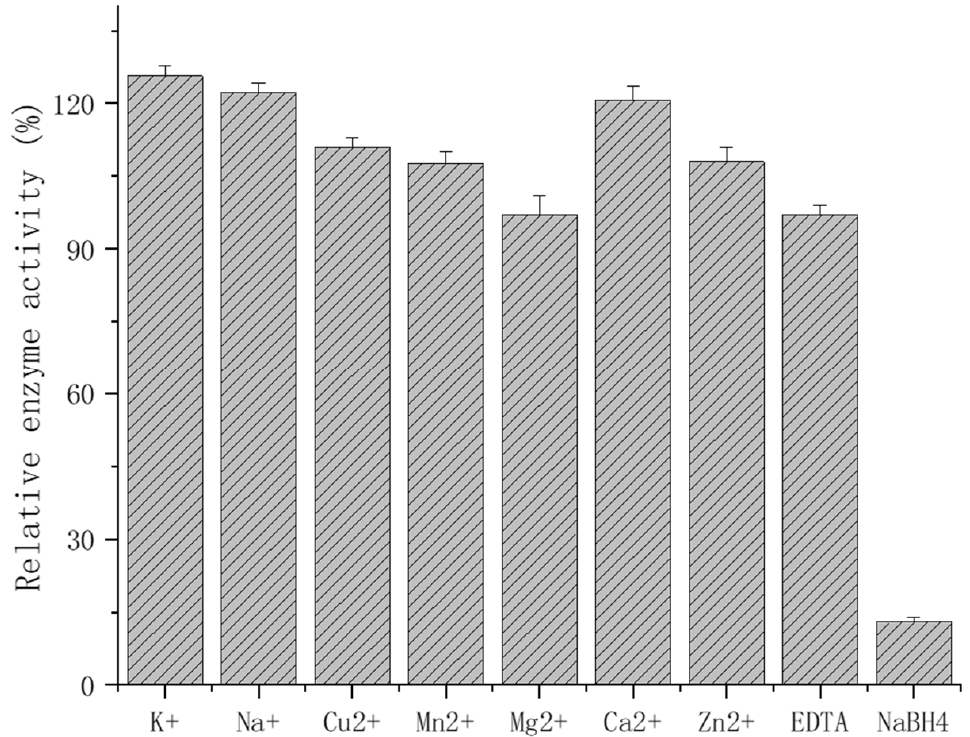
Figure 6. EsFBA activity in the presence of metal ions.